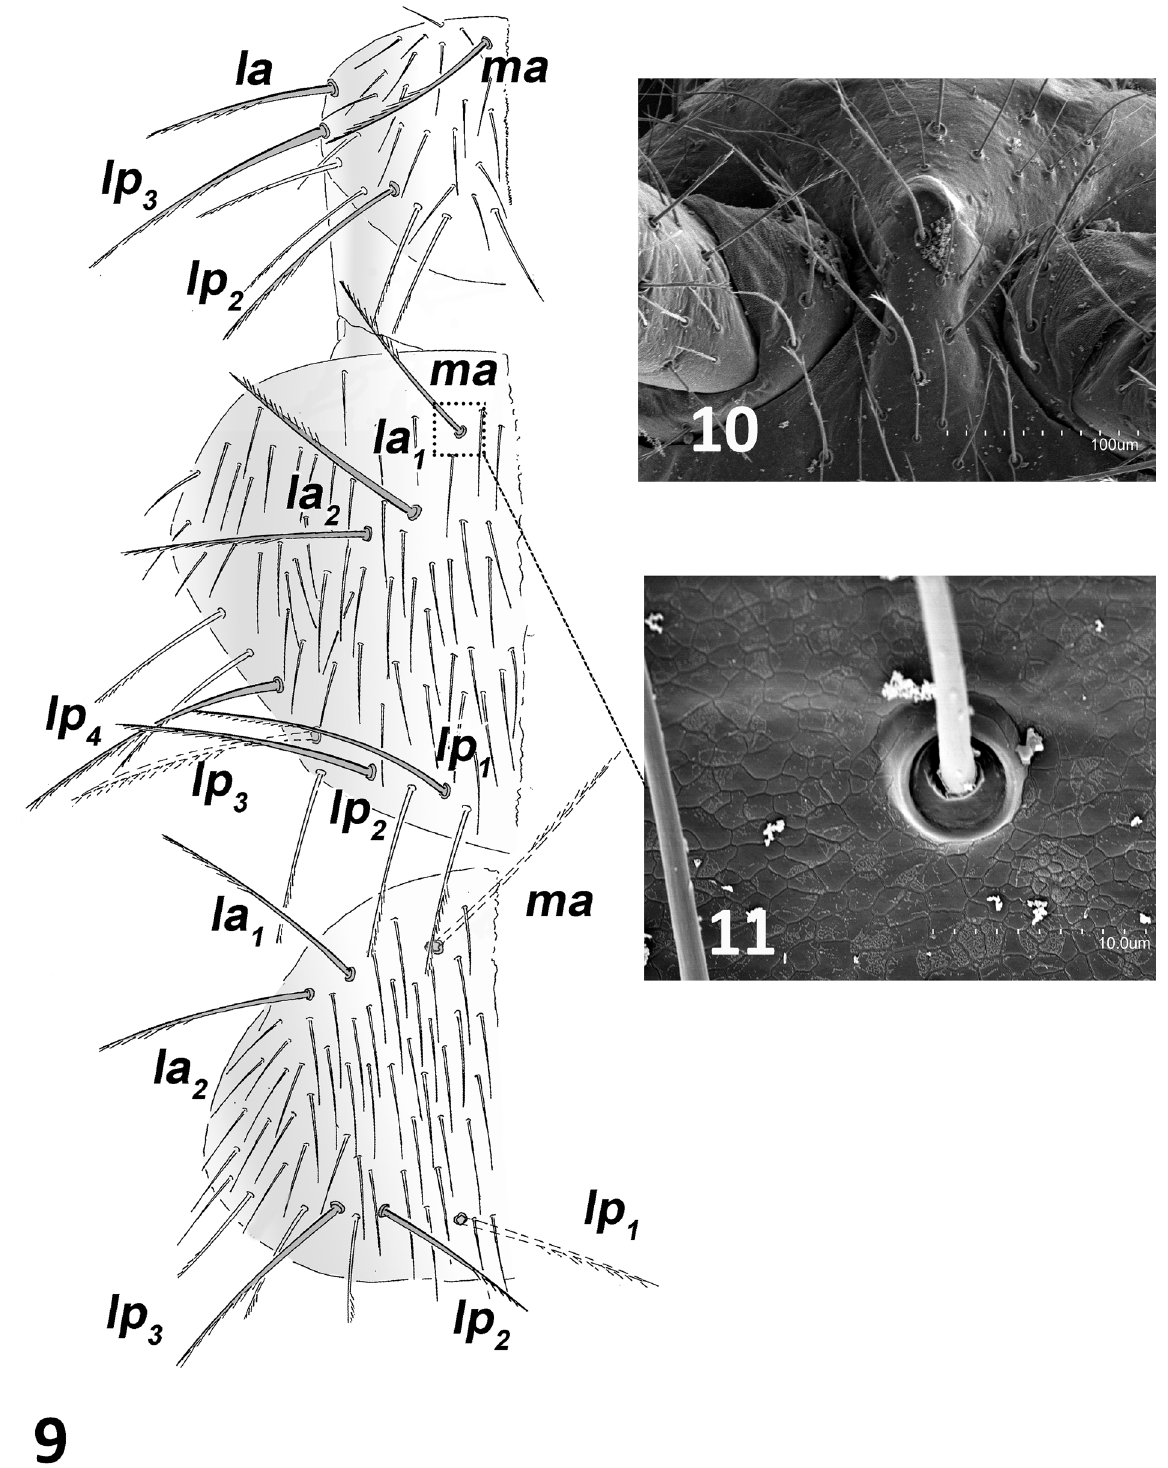
Figs 9‒11. Anisuracampa ywangana Sendra & Komerički sp. nov., holotype (MZB (MCNAB) 2020- 1152) 9 . Pronotum, mesonotum, and metanotum, left side. 10 . Frontal process. 11 . Detail of the base of medial anterior mesonotal